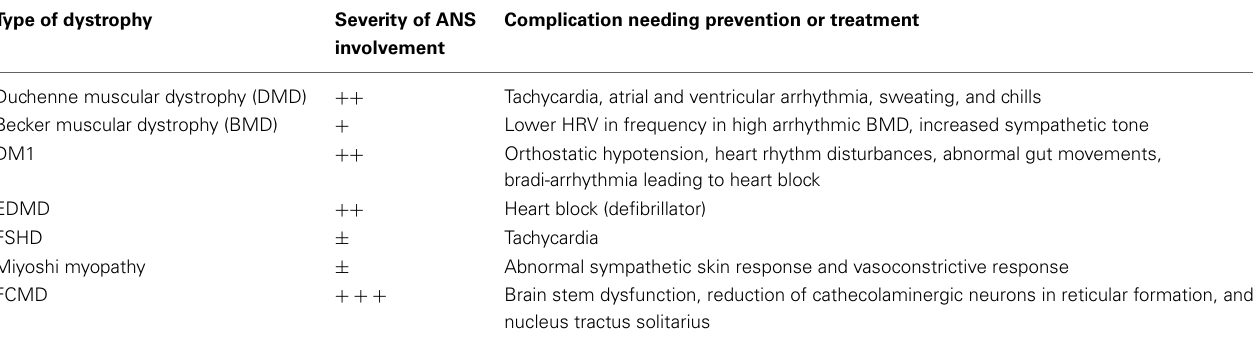
Table 1 | Autonomic dysfunctions in various types of muscular dystrophies. Type of